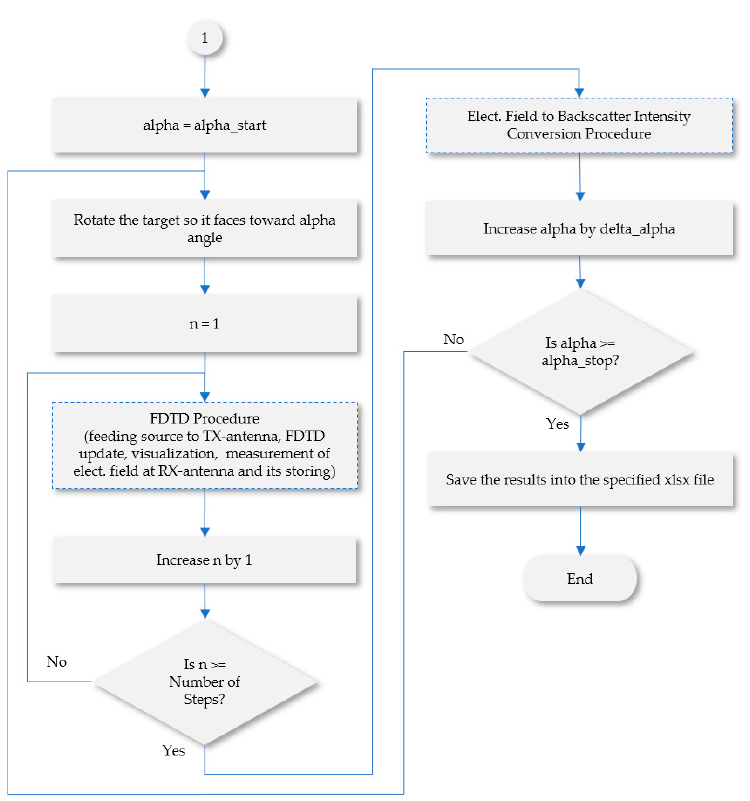
Figure 4. Critical design review of AST_V1 presented in a flow chart (part 2).